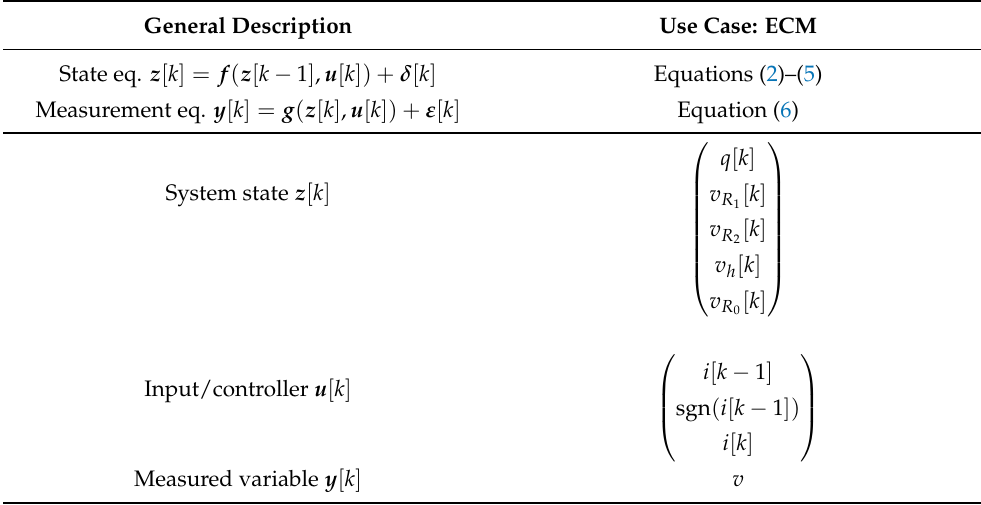
Table 2. Comparison of the general description of the EKF and the used equivalent circuit model of a battery